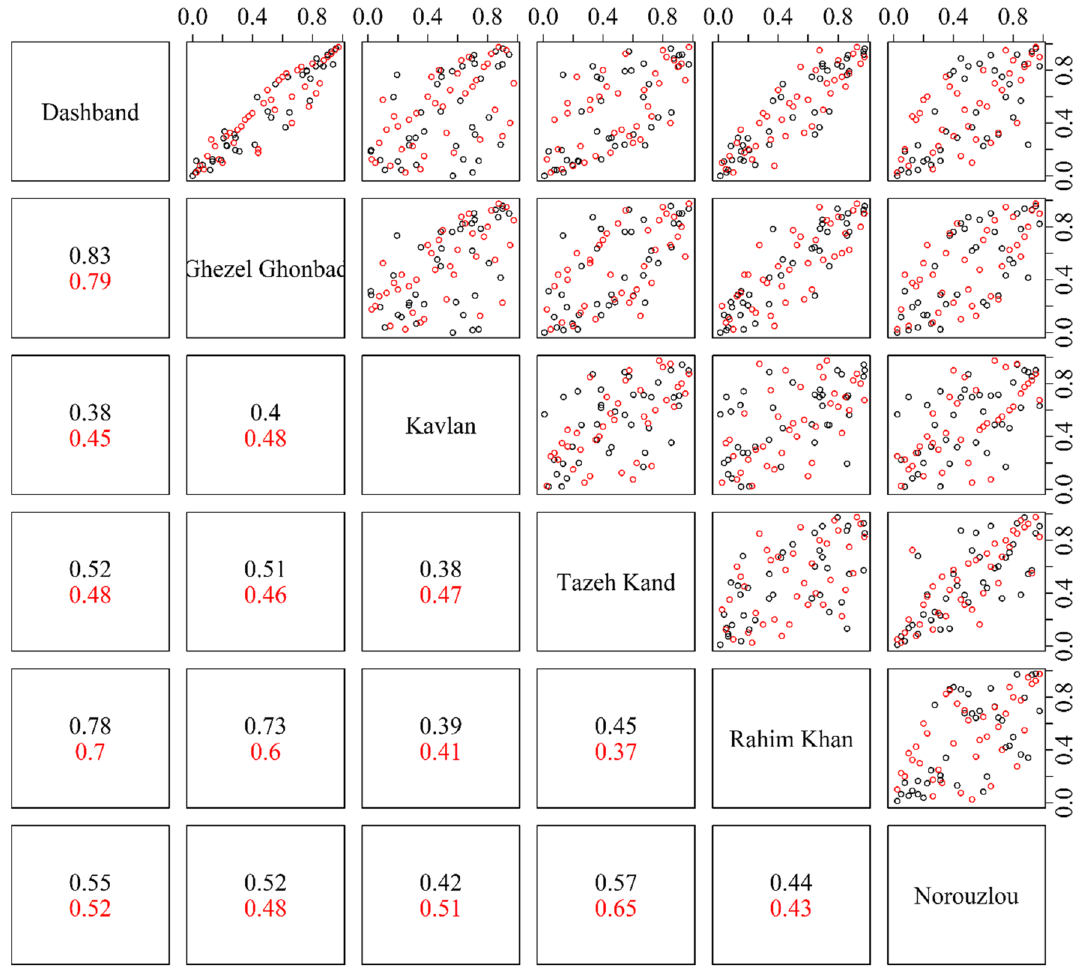
Fig. 5 The correlation between the observed and simulated annual rainfall values of the stations (red: observed data; black, simulated